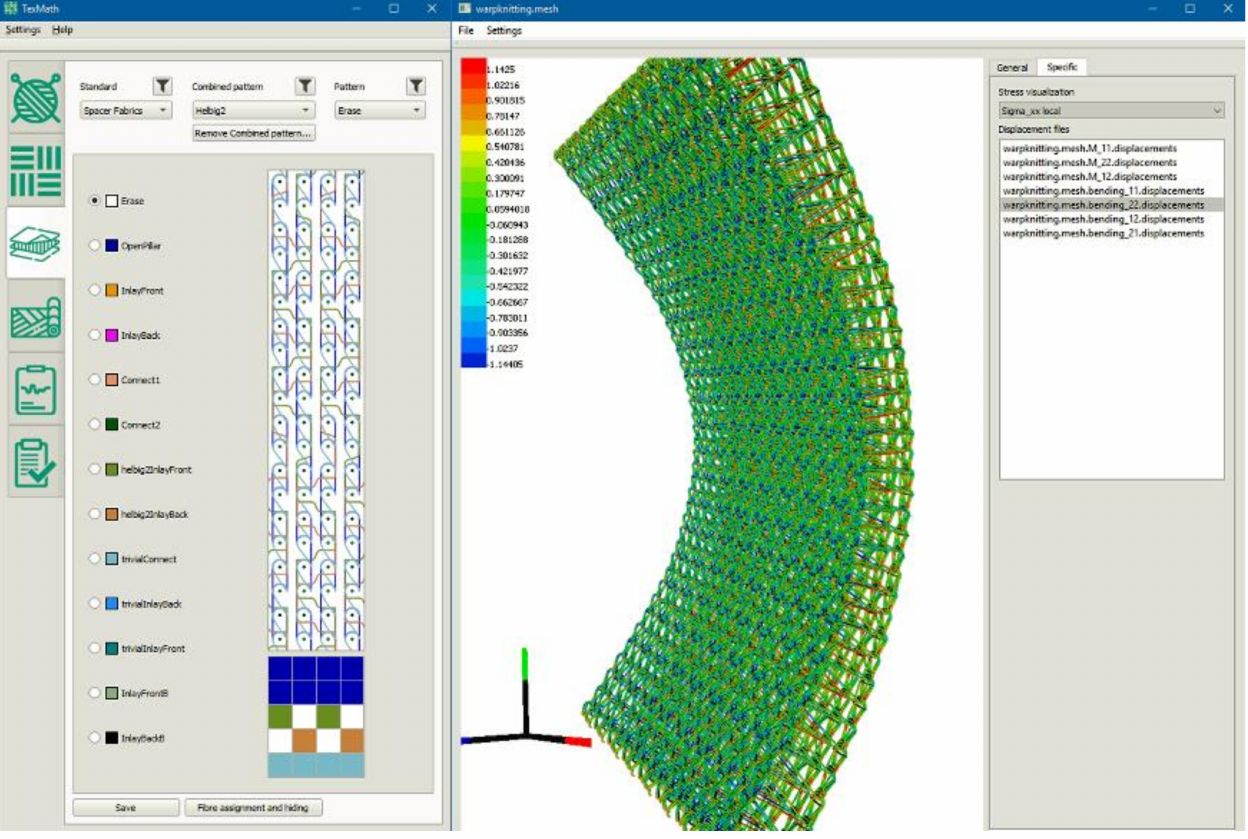
Figure 21. Structure generation and bending simulation of a spacer fabric. ©Fraunhofer